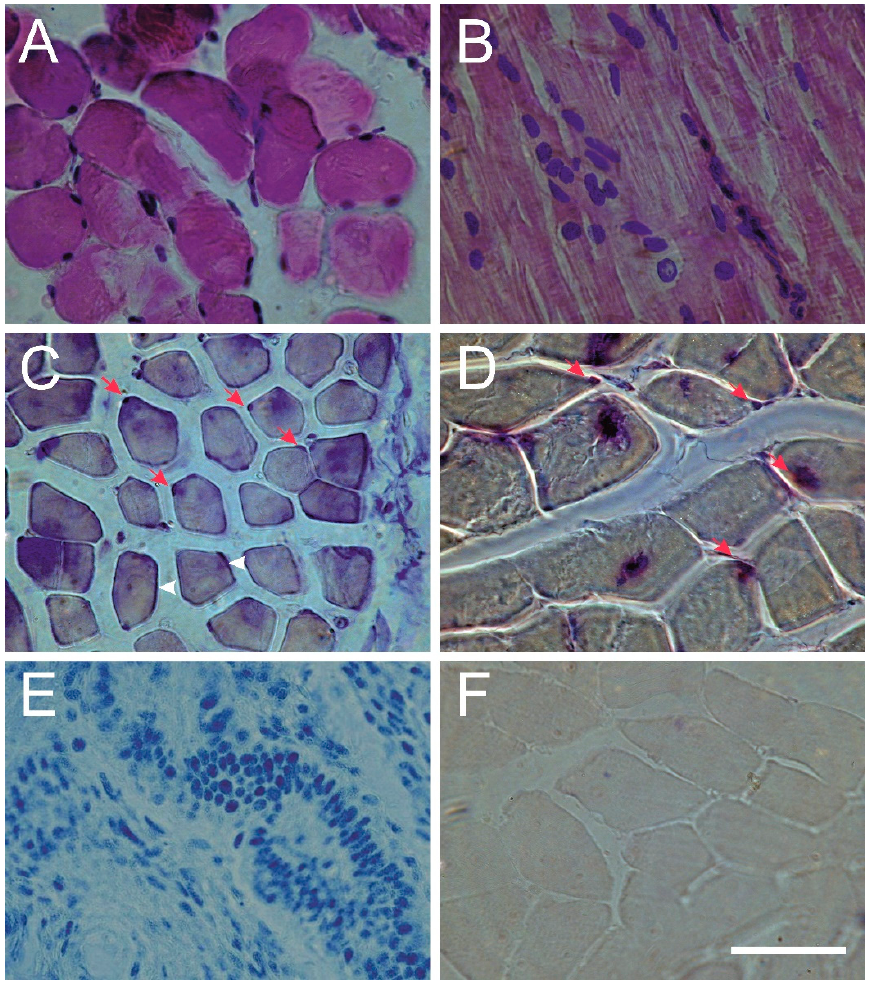
Figure 2. Immunohistochemical examination of the muscle tissue of individual patient. ( A – D ) and controls ( E , F ). Hematoxylin and eosin staining (( A )—cross-section, ( B )—longitudinal-section; skeletal muscles were identified by peripheral nuclei and large amounts of cytoplasm). Immunolocalization of the ESR1 ( C ) and ESR2 ( D ) presence (purple color). ESR1 and ESR2 were detected in the nuclei of the back muscle cells (red arrows); ESR1 expression was also observed in the muscle cell membrane (white arrowhead). Endometrial control tissue–positive control ( E ), and muscle tissue–negative control ( F ). In the negative control, the primary antibody was omitted. Scale bar = 100 µm.